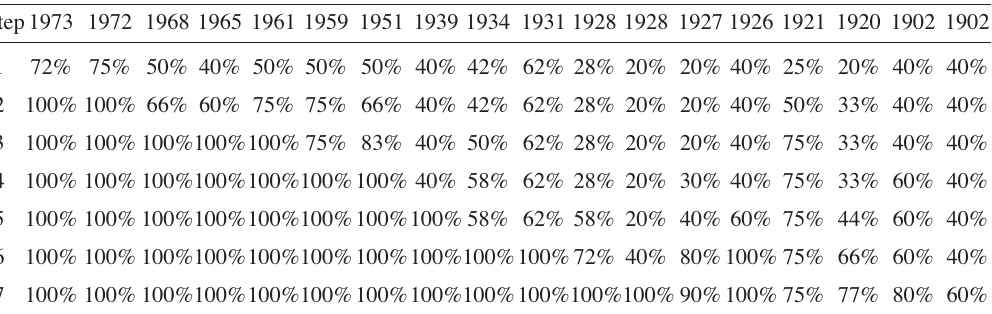
Fig. 3. Velocity propagation model (left panel) and position of stations used for this study. For each station, the correction factor is reported (circle for negative values, triangle for positive; size is proportional to the amount) as after the computation process resumed in table I. The distribution of delays is close to the optimal, being very nicely distinct the positive and negative areas (Kissling et al. , 1995). The box with dashes shows the approxi- mate extension of the Lunigiana-Garfagnana area. Table I. Evolution of the computation of delays for the seismic observatories the readings of which are used in this work. At increasing steps the number of known stations corrections (in percentage with respect to the total number) expands, and even observatories that no longer operate can be taken into